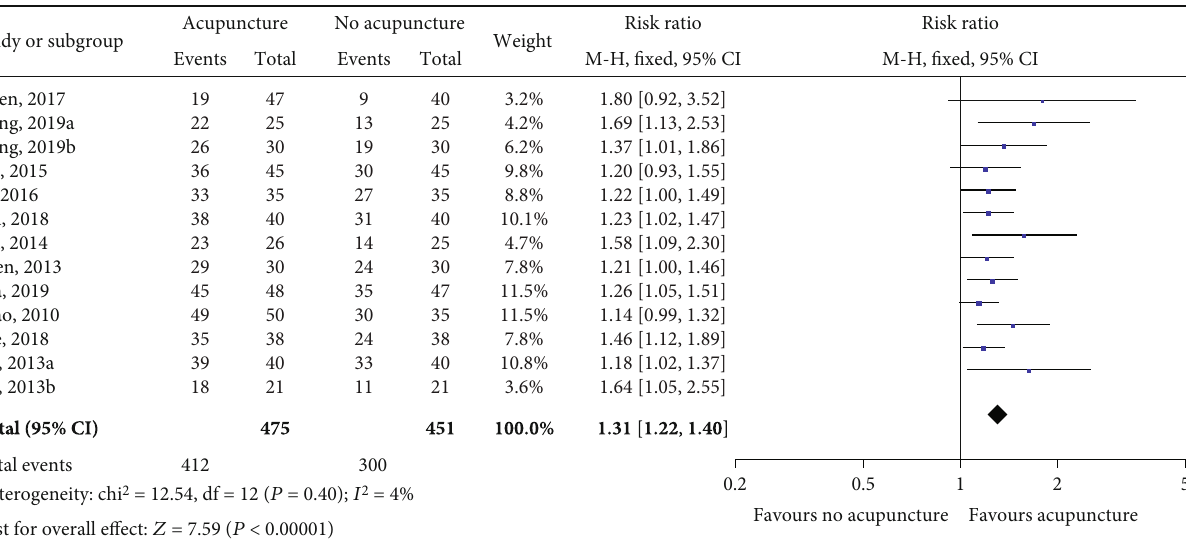
Figure 3: The e ffi cacy rate of acupuncture versus no acupuncture. Both I 2 and P are used as the criteria for heterogeneity test. ♦ : pooled relative risk; — ■ — : relative risk and 95% CI.